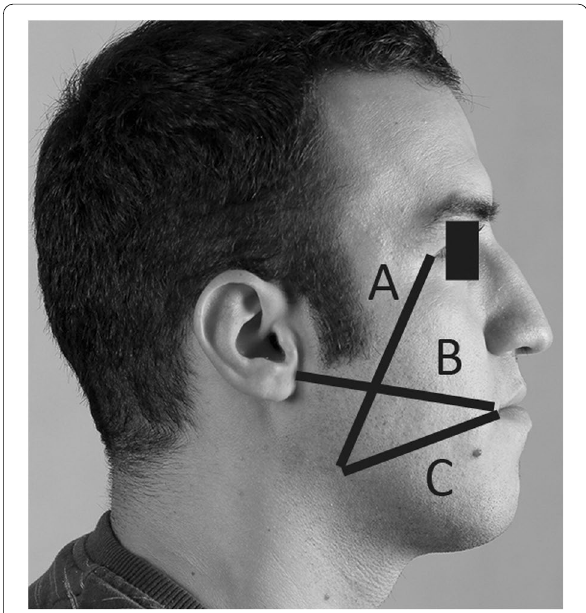
Fig. 2 Postoperative edema linear demarcation measures. Line A is the vertical dimension to assess the swelling. Lines B and C are the assessment lines to evaluate the oblique and horizontal swelling, respectively